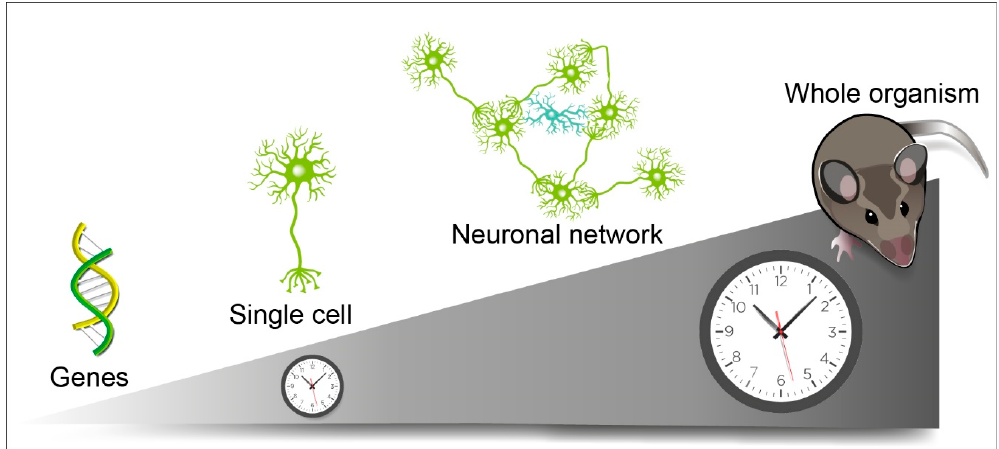
Figure 1. The robustness of circadian rhythms observed at the organism level emerges from cell networks in the suprachiasmatic nuclei (SCN). A genetically encoded clock drives self-sustained circadian rhythmicity in individual cells. Intercellular coupling in the SCN coordinates cell-autonomous rhythms into a coherent and resilient circadian pacemaker that tunes all the body rhythms. Green and blue cells depict SCN neurons and astrocytes, respectively.